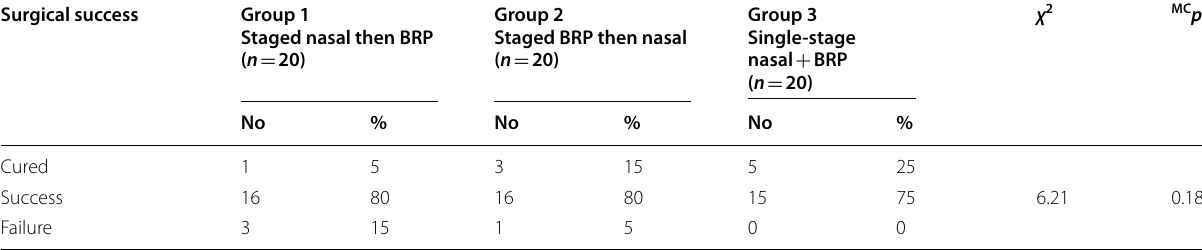
χ 2 , p χ 2 and p values for chi-square test for comparing between the two groups, MC p p value for Monte Carlo for chi-square test for comparing between the three groups